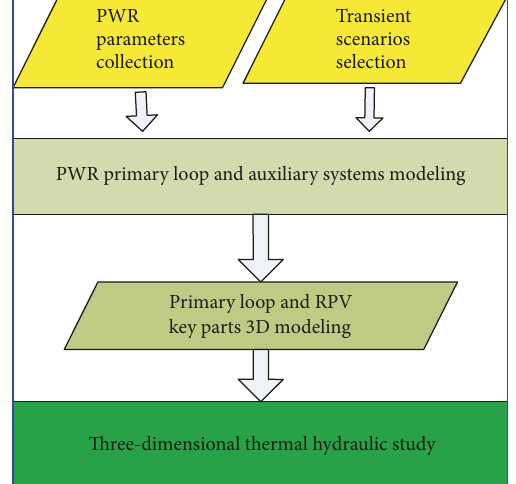
Figure 1: The procedure diagram of multiscale thermal hydraulic